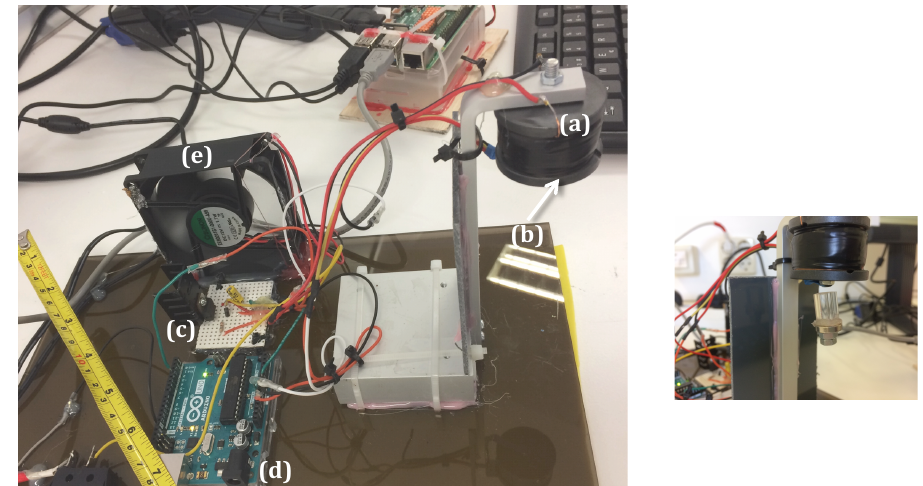
Figure 1. A low-cost experimental platform for electromagnetic levitation control design. Main parts ( left ): ( a ) actuator coil; ( b ) Hall-effect sensor; ( c ) power amplifier; ( d ) Arduino Uno microcontroller; and ( e ) a fan to dissipate heat from the power amplifier. ( Right ): Photo of the object being levitated.